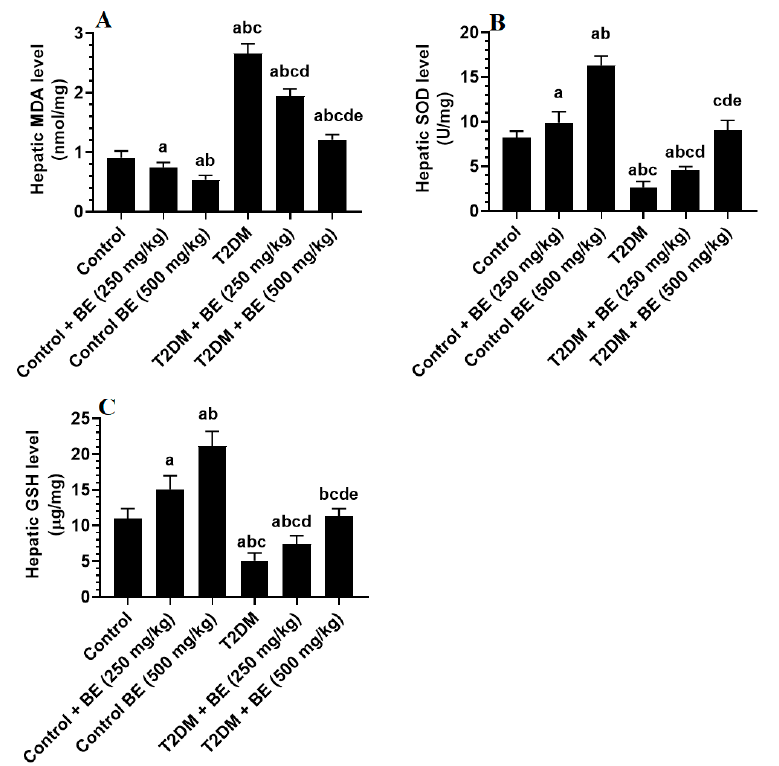
Figure 2. Levels of malondialdehyde (MDA) ( A ), superoxide dismutase (SOD) ( B ), and total reduced glutathione (GSH) ( C ) in the livers of all groups of rats. Data were analyzed by one-way ANOVA followed by Tukey’s test as post hoc and presented as mean ± SD of eight rats/group. a : vs. the control rats. b : vs. the control + beetroot extract (BE) (250 mg/kg)-treated rats. c : vs. the control + BE (500 mg/kg)-treated rats. d : vs. T2DM-treated rats. e : vs. T2DM + BE (250 mg/kg). 3.4. BE Attenuates Serum Transaminases and Hepatic Inflammatory Markers in T2DM Rats Serum levels of ALT and AST and hepatic levels of TNF- α and IL-6 were not signif- icantly different between control and control + BE (250 and 500 mg/kg) (Figure 3A–D). Levels of ALT and AST and hepatic levels of TNF- α and IL-6 were significantly higher in T2DM-induced rats compared to control rats, but progressively decreased in T2DM + BE (250 and 500 mg/kg) when compared to T2DM-induced rats (Figure 3A–D). Serum levels of ALT remained slightly increased, whereas serum levels of AST and hepatic levels TNF-